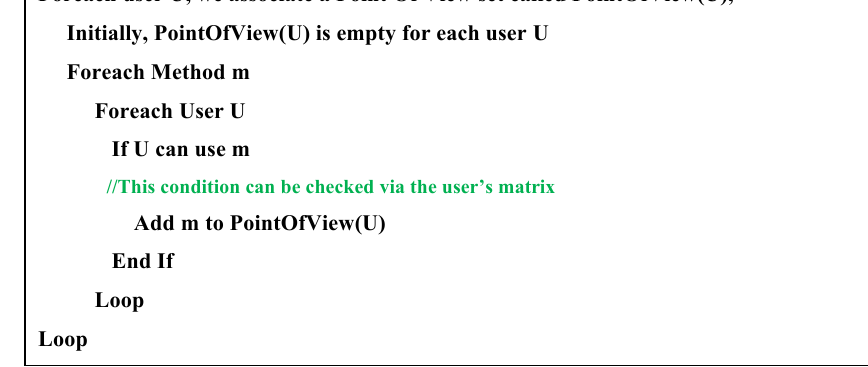
Fig. 2. Inference algorithm of Points of view automatic generation